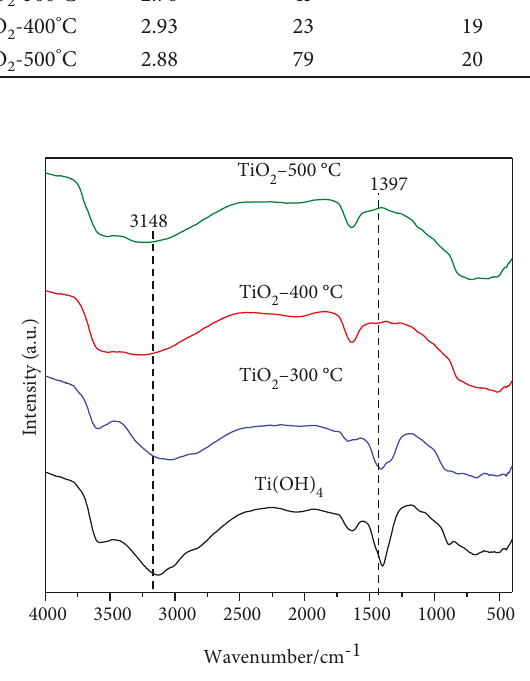
Figure 4: FTIR spectra of Ti(OH) TiO -500 ° 2